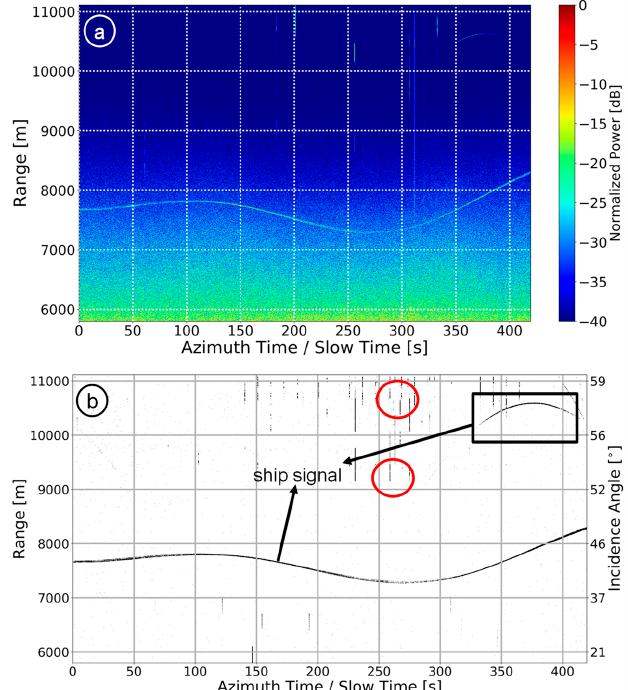
Figure 31. ( a ) Circularly acquired real single-channel HH polarized RC L-band radar data. ( b ) Binary detection map shown in time-domain after applying CFAR based ship detection in range–Doppler domain. K-Rayleigh distribution was used in the near and mid ranges, and the 3MD model was used in the far range of the data. The desired false alarm rate was set to P fa = 10 − 6 . The detections marked by the red circles are due to the interfering signals from a ground surveillance radar located close to the test site (for visualization purposes not all of the interfering signals are marked).